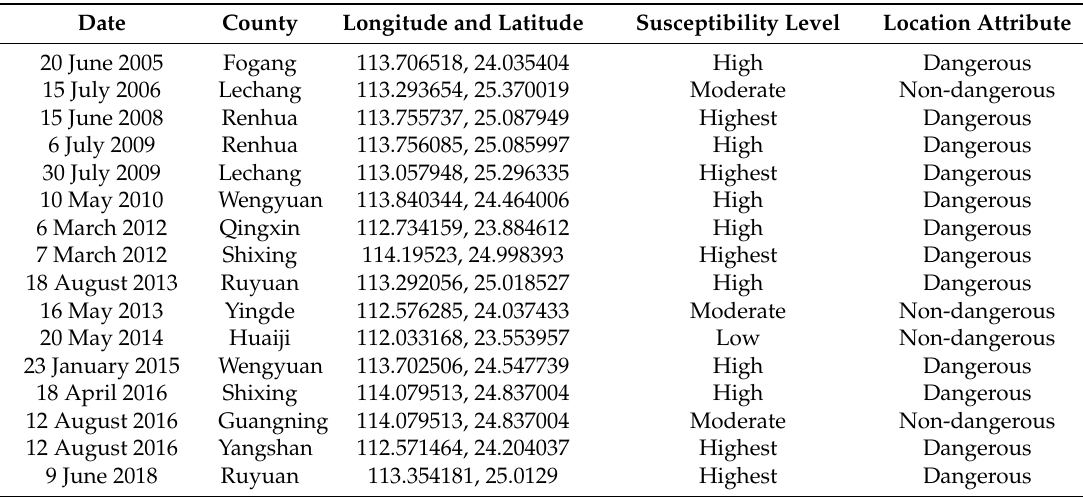
Table 6. Verification sample occurred in the Beijiang River Bain after May,